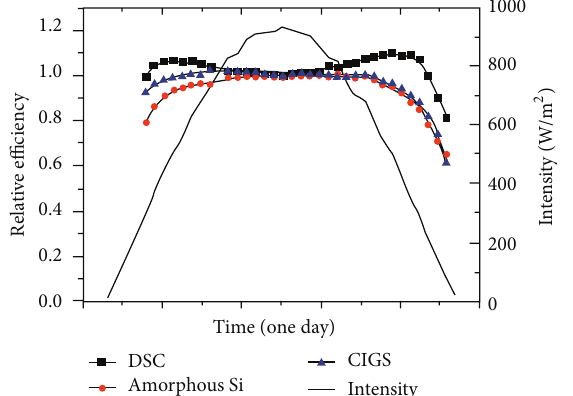
Figure 1: Data from comparative I - V measurements of DSC, amor- phous Si and CIGS modules, on the roof top [5].